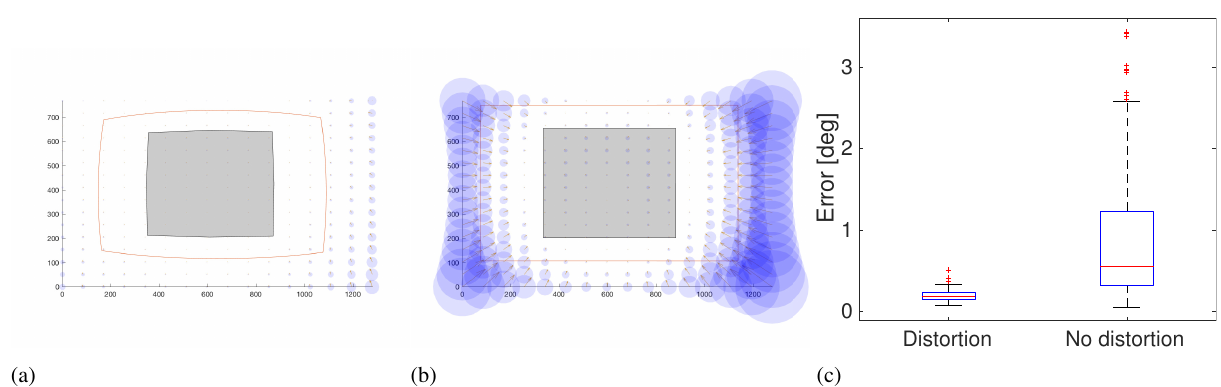
Figure 14 . Gaze estimation error in the scene image showing the e ff ect of radial distortion on polynomial function 1 (3 × 3 calibration points) (a) with and (b) without lens distortion. The error in the working area for both conditions is shown in (c).